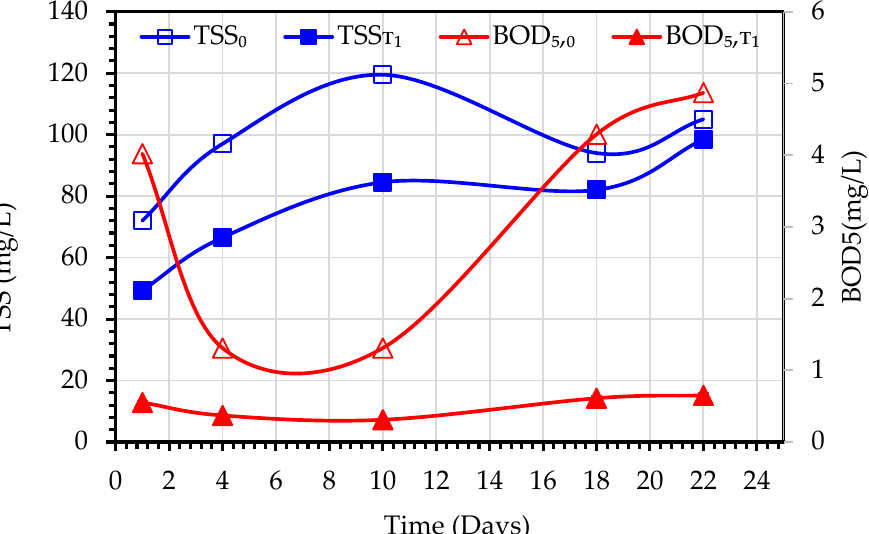
Figure 7. Variations of BOD5 and TSS values observed during the treatment of secondary wastewater using a hybrid MBBMR and DCMD system (Experiment 1).